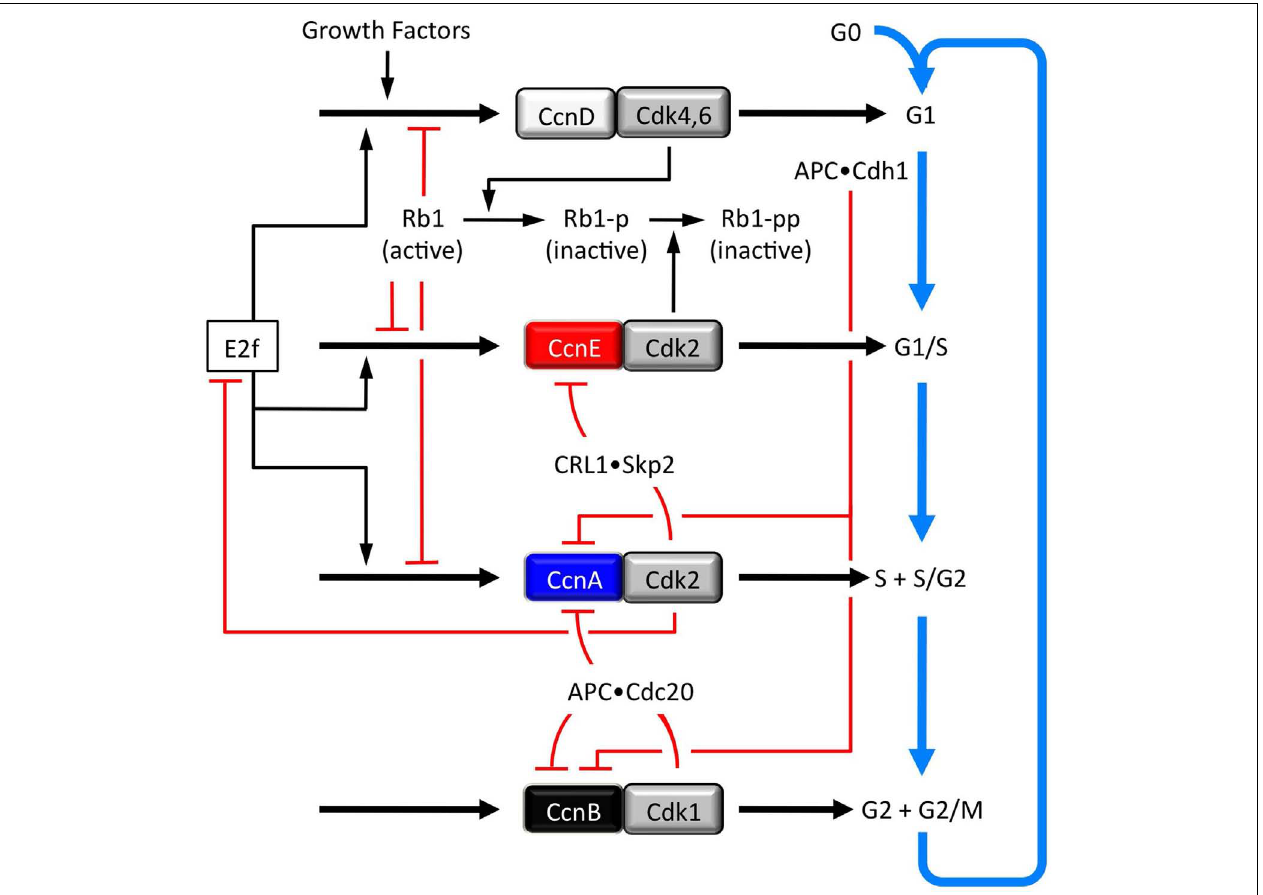
FIGURE 3 | Four CDK • cyclin activities regulate progress through successive phases of the mitotic cell cycle (adapted from Gerard and Goldbeter, 2009). Growth factors activate the synthesis of the transcription factor Ap1, which promotes synthesis of CcnD, which forms a